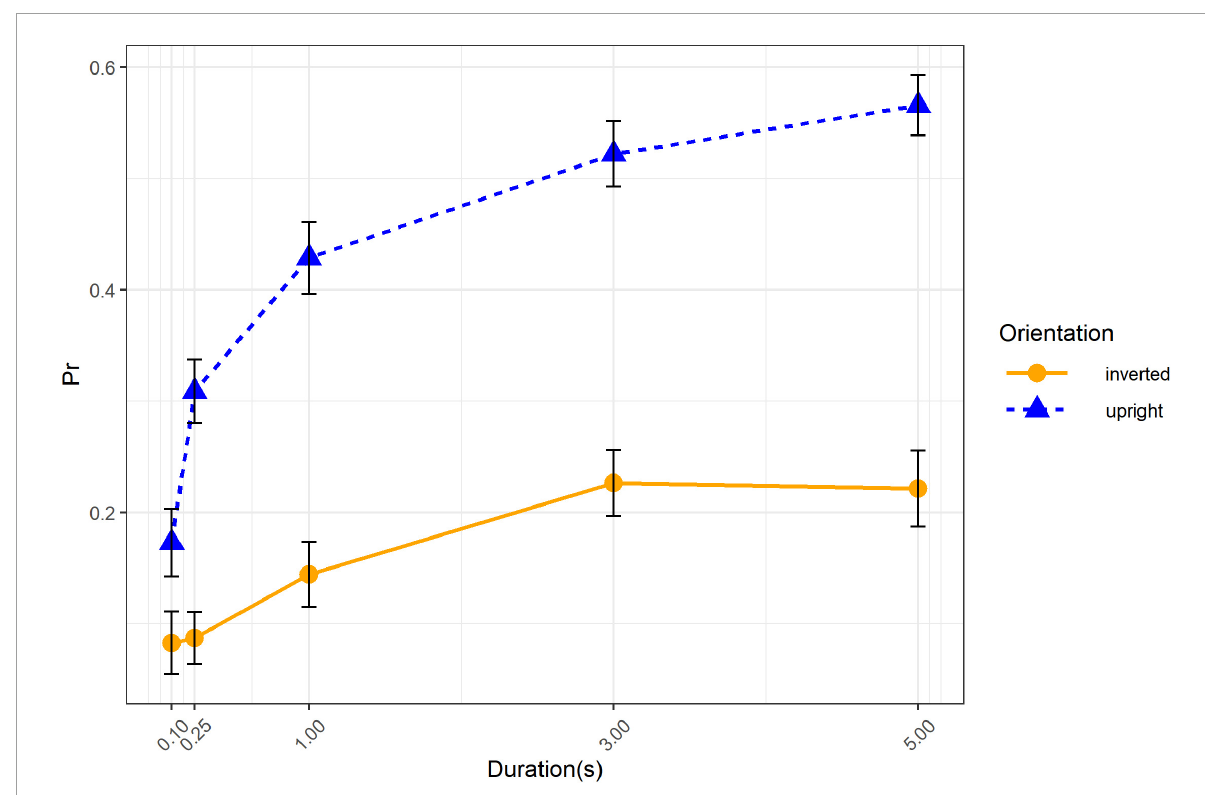
FIGURE3 Recognition performance as a function of orientation and duration. Error bars represent standard